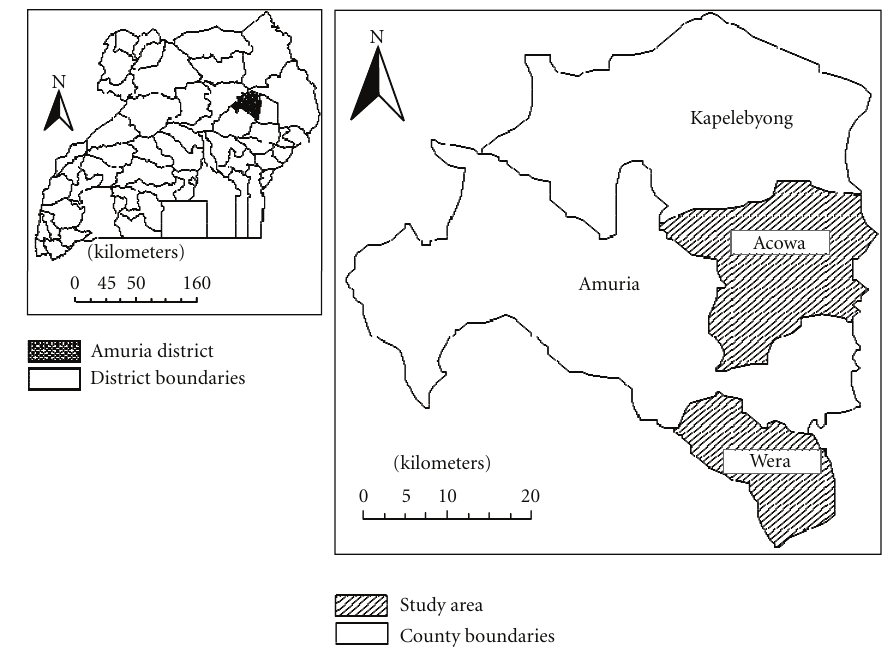
Figure 1: Location of the study area in Uganda.